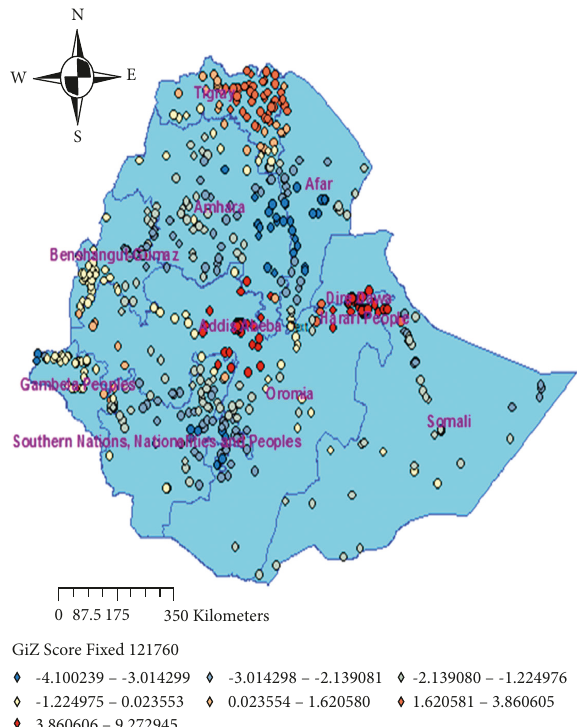
Figure 3: Hot spot analysis of institutional delivery in Ethiopia, EDHS 2016 (source: shape file from CSA, 2013, done using ArcGIS version